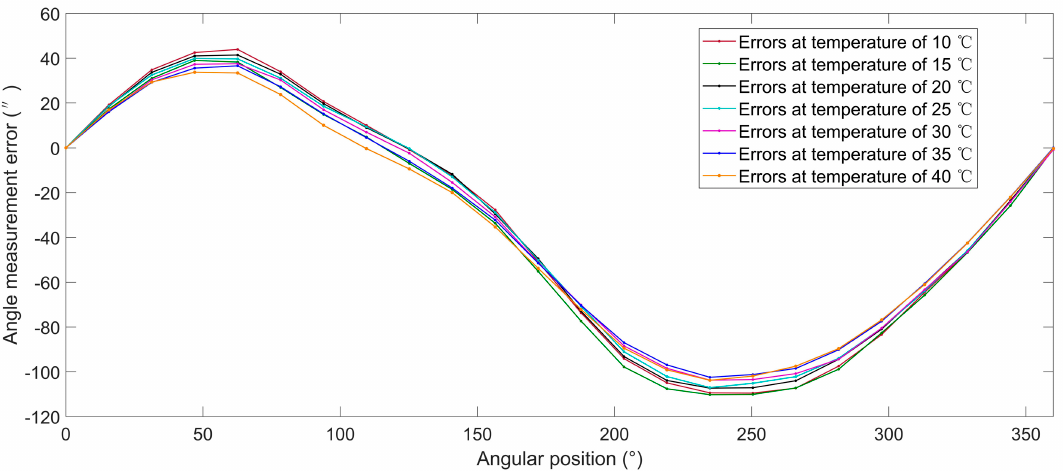
Figure 7. Average angle measurement error before calibration.